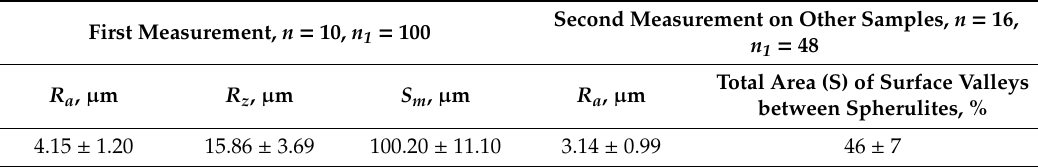
Table 1. Topography parameters of titanium substrates with microarc rough CaP coating, mean (X) ± standard deviation (SD).